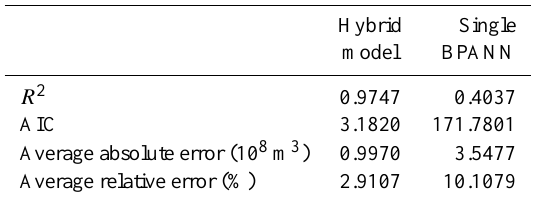
Table 3. Comparison of simulated effect between the hybrid model and the single